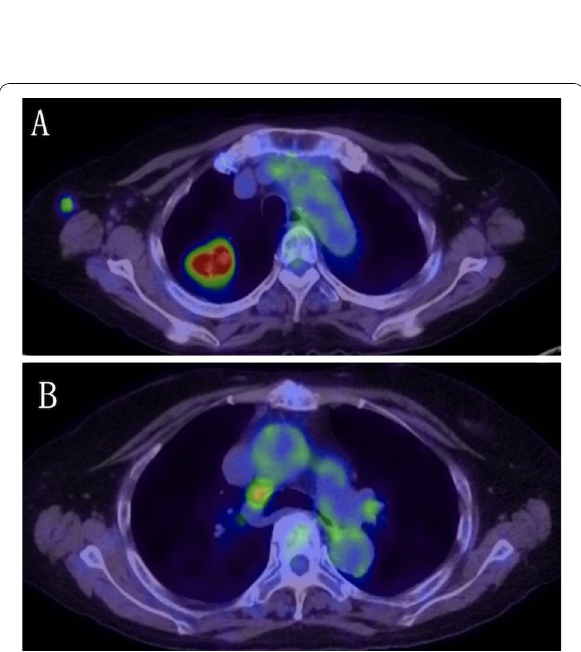
Fig. 2 A 18F-fluorodeoxyglucose (FDG) positron emission tomography scan shows FDG accumulation with a maximum standardized uptake value (SUVmax) of 11.78 in the mass and B FDG accumulation with a SUVmax of 3.48 in the right lower paratracheal lymph node (station